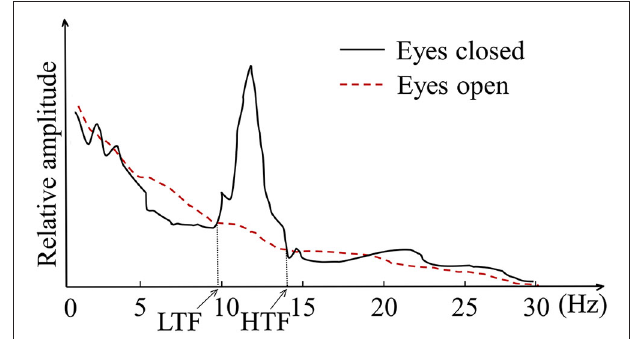
FIGURE 1 | The illustration of individual alpha frequency band .